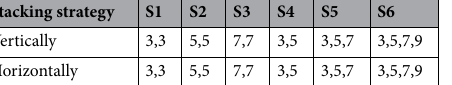
Table 6. Various schemes in the proposed MFFS for different stacking strategy.